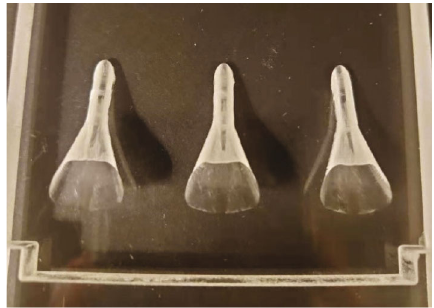
Figure 6: Machined test piece of θ = 21 ° before testing.